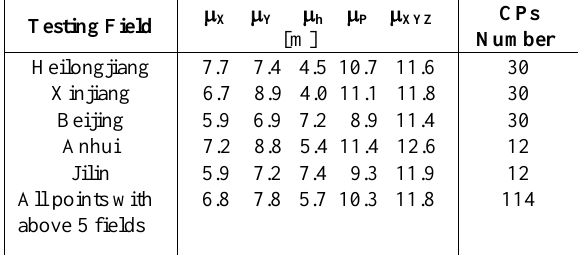
Table 3. Statistics of location accuracy without GCPs